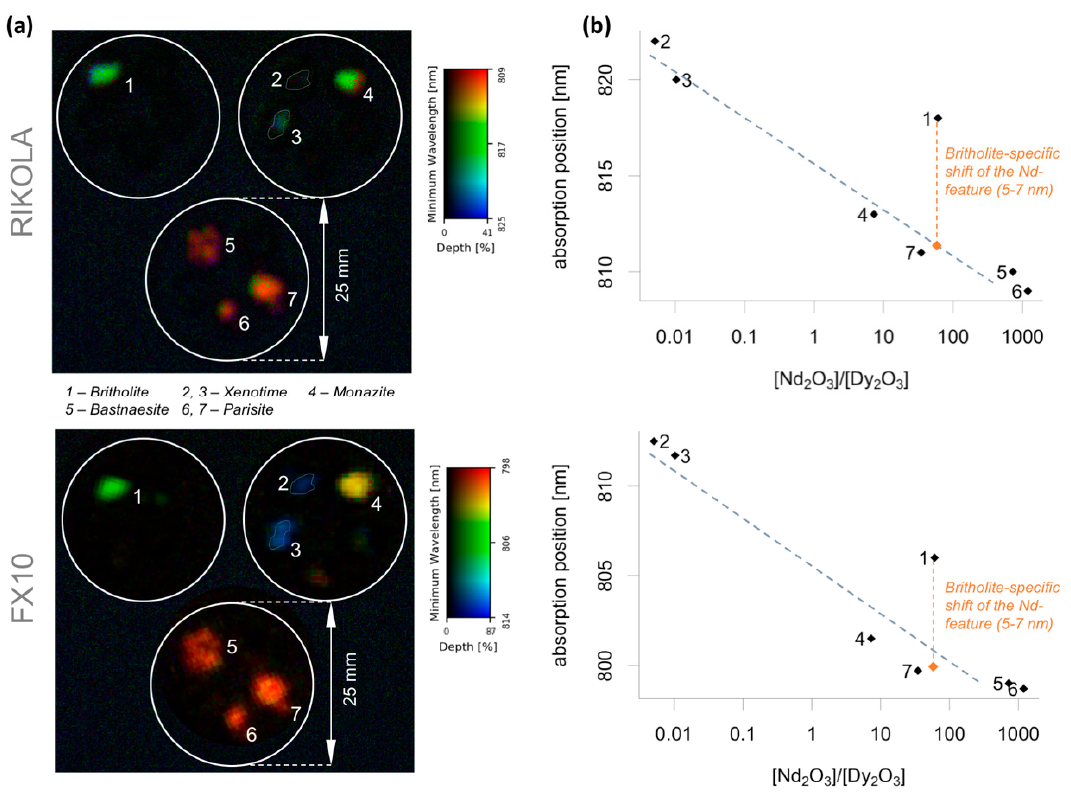
Figure 4. Relation between relative abundances of different REE and observed absorption feature position for both used HS imagers: ( a ) Reflectance minimum wavelength mapping in the range of 790 and 860 nm for three natural mineral sample batches and ( b ) scatter plot between observed minimum wavelength and the respective ratio of EMPA derived Nd 3+ and Dy 3+ concentrations for seven sample grains marked in (a).